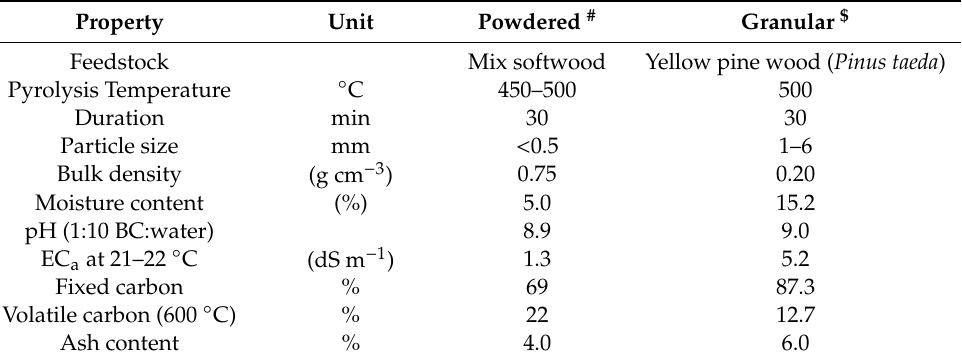
Table 1. Basic properties of two types of biochar (BC) used for the study. Property